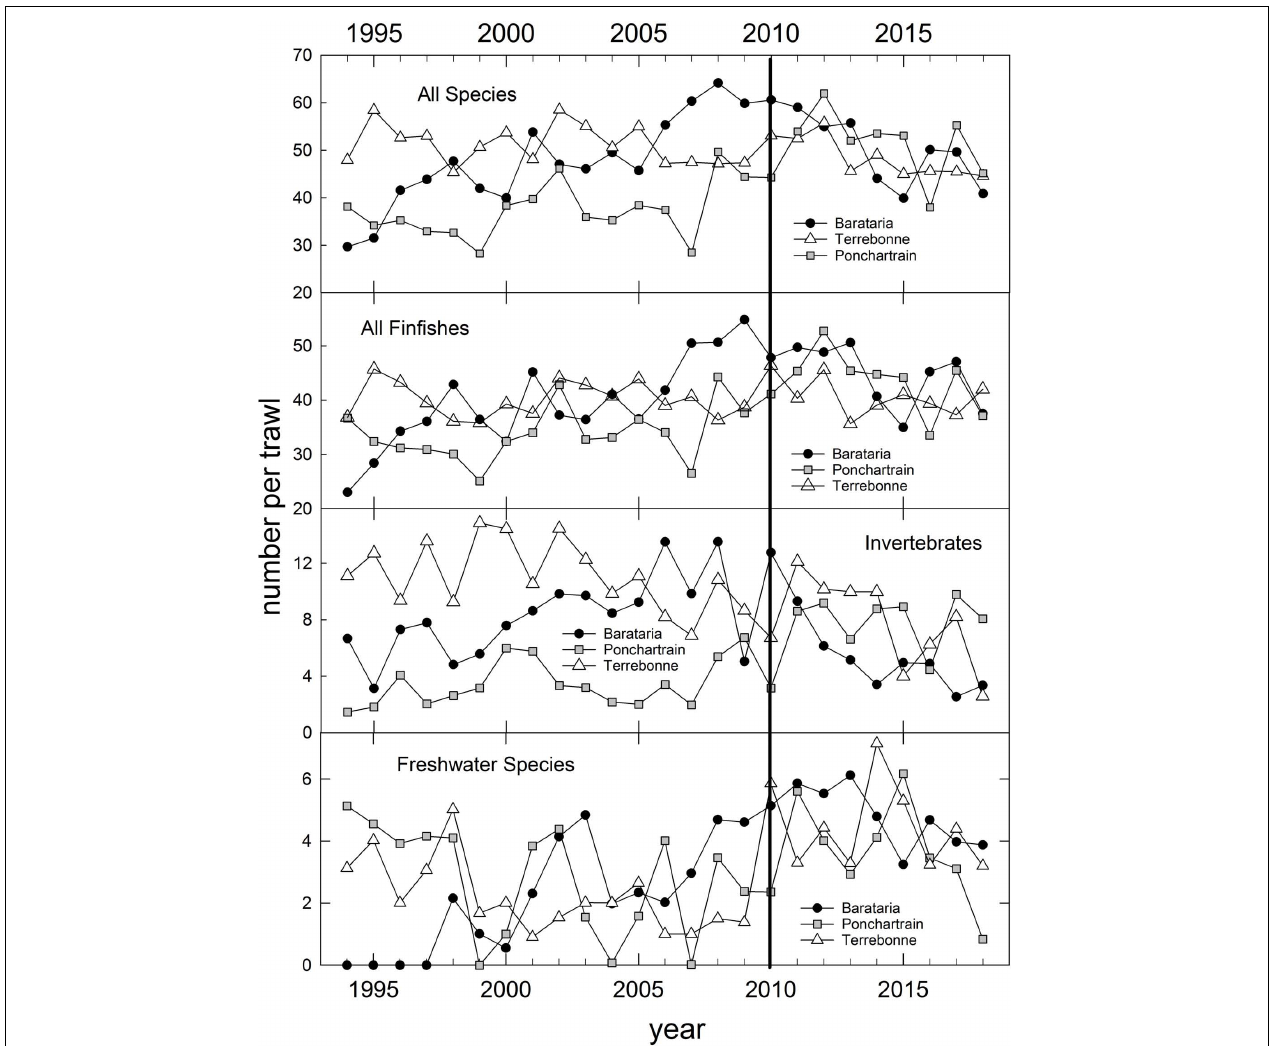
FIGURE 3 | Annual relative abundance of all species catches and three species groups ( Supplementary Table 1 ) caught in fishery-independent trawl sampling by the Louisiana Department of Wildlife and Fisheries, in three Louisiana coastal basins, 1994–2018. Data are inverse-variance weighted mean catches trawl - 1